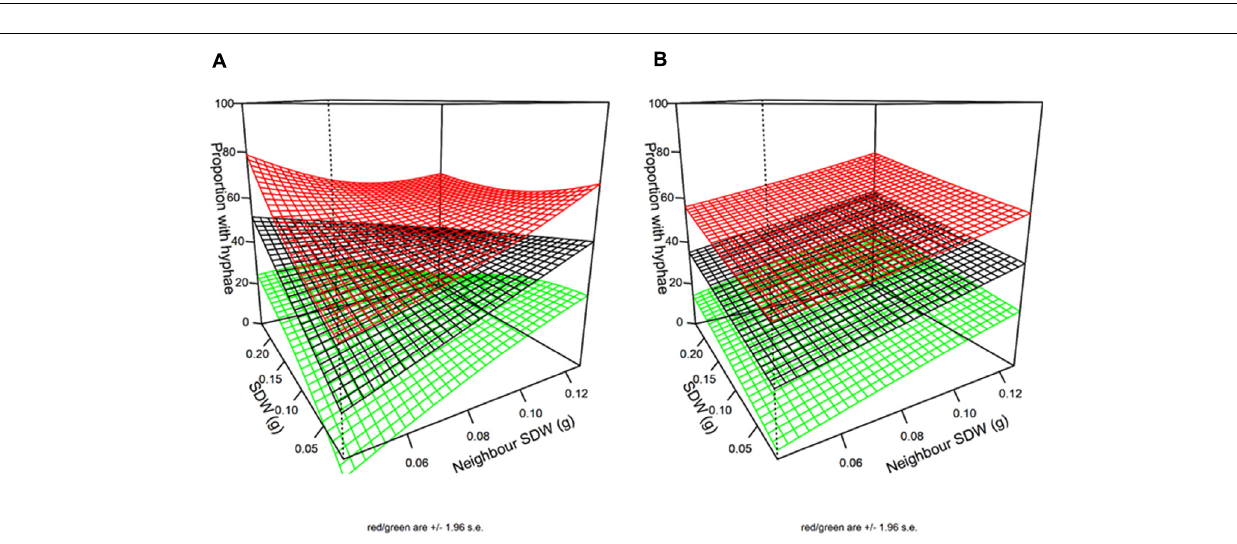
FIGURE 5 | Boxplots of SDWs of each treatment, and hyphal colonization in the four main rice subgroups.